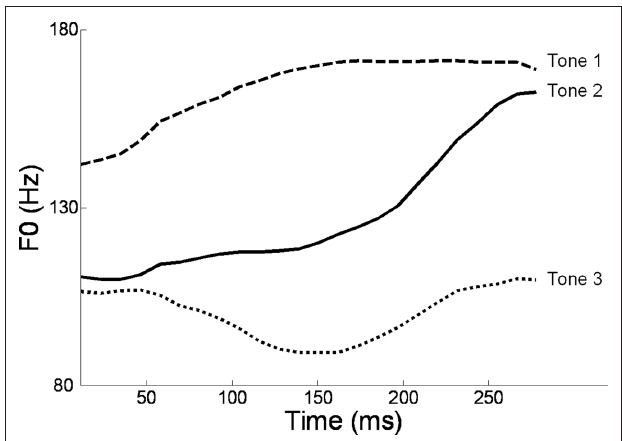
FiguRE 6 | F0 contours of the three Mandarin tones used in the study of Song et al. (2008): high-level (tone 1), rising (tone 2), and dipping/falling–rising (tone 3). Reproduced with permission.